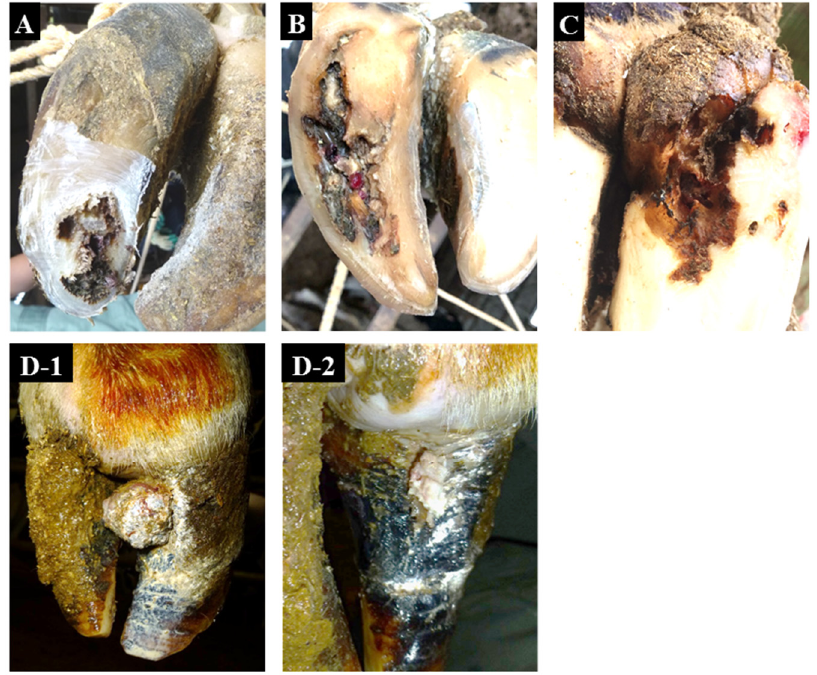
( B ), non-healing white line disease (No. 4). ( C ), non-healing sole ulcer (No. 7). ( D-1 ), non-healing Figure 1. Representative non-healing claw lesions examined in this study. A, toe necrosis (No.3). B, non-healing white verrucous-like lesion (No. 12) before surgical excision. ( D-2 ), non-healing verrucous-like lesion line disease (No.4). C, non-healing sole ulcer (No.7). D-1, non-healing verrucous-like lesion (No.12) before surgical (No. 12) after surgical excision. D-2, non-healing verrucous-like lesion (No.12) after surgical excision.